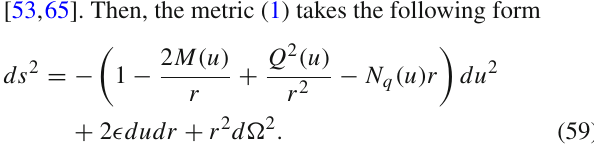
cases of Q = − 1 , 0 and + 1, respectively. The plots d , e represents the case of L = − 1 , 0 and + 1. The plots f – h represent of N = − 1 , 0 and +